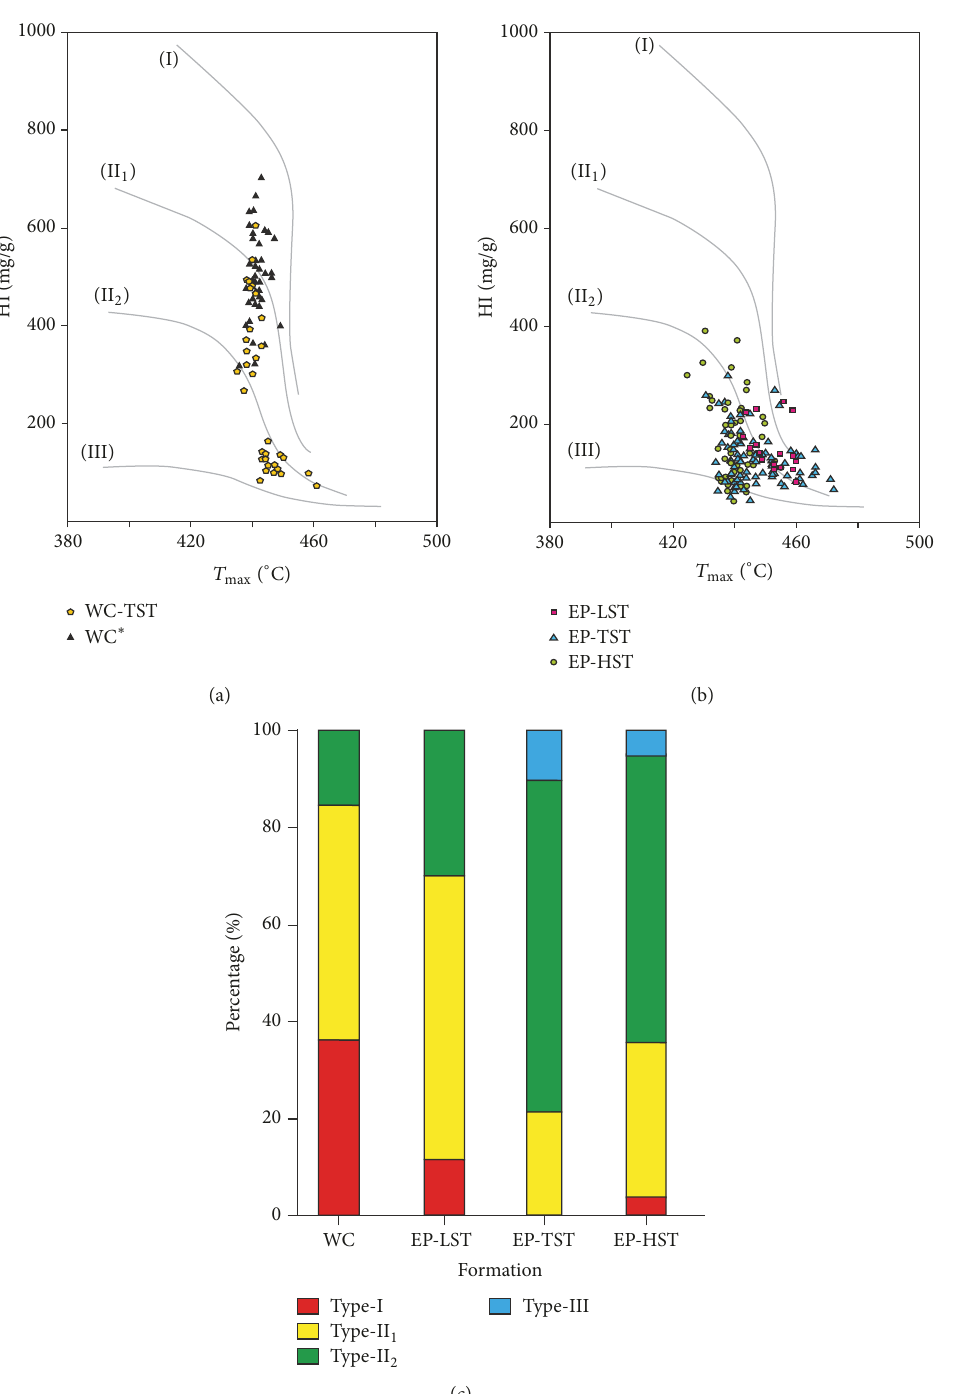
Figure 4: Kerogen types of the Eocene Wenchang and Enping source rocks in the Huizhou Sag (HI: hydrogen index, mg/g; 𝑇 max : the pyrolysis temperature at maximum amount of generated hydrocarbons, ∘ C; WC: the Wenchang Formation; EP: the Enping Formation; LST: lowstand systems tract; TST: transgression systems tract; HTS: highstand systems tract; WC ∗ : data from